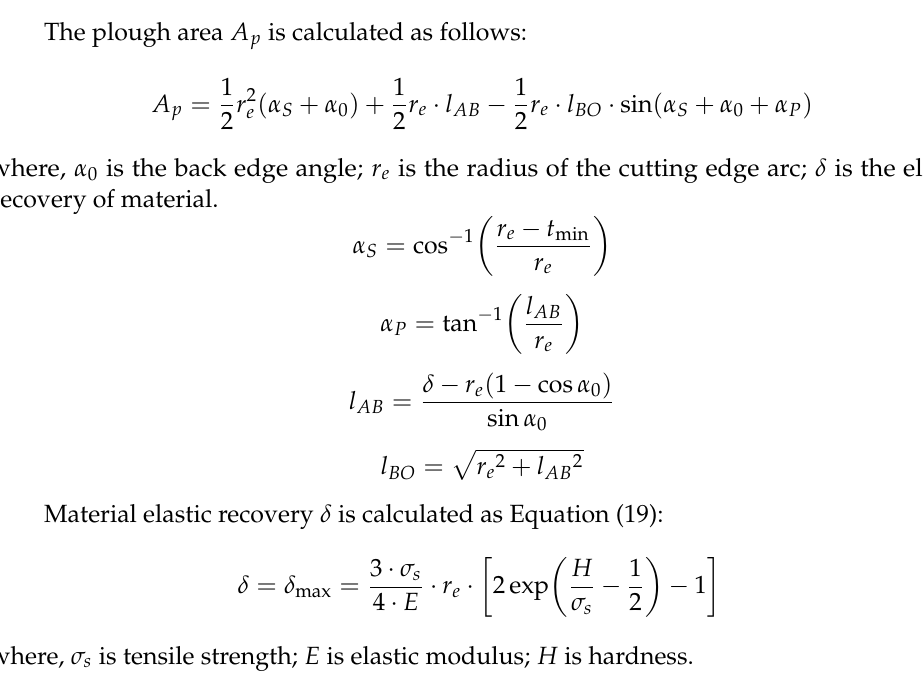
Figure 10. Plough area: ( a ) δ < t c < t min ; ( b ) t c < δ < t min . The plough area